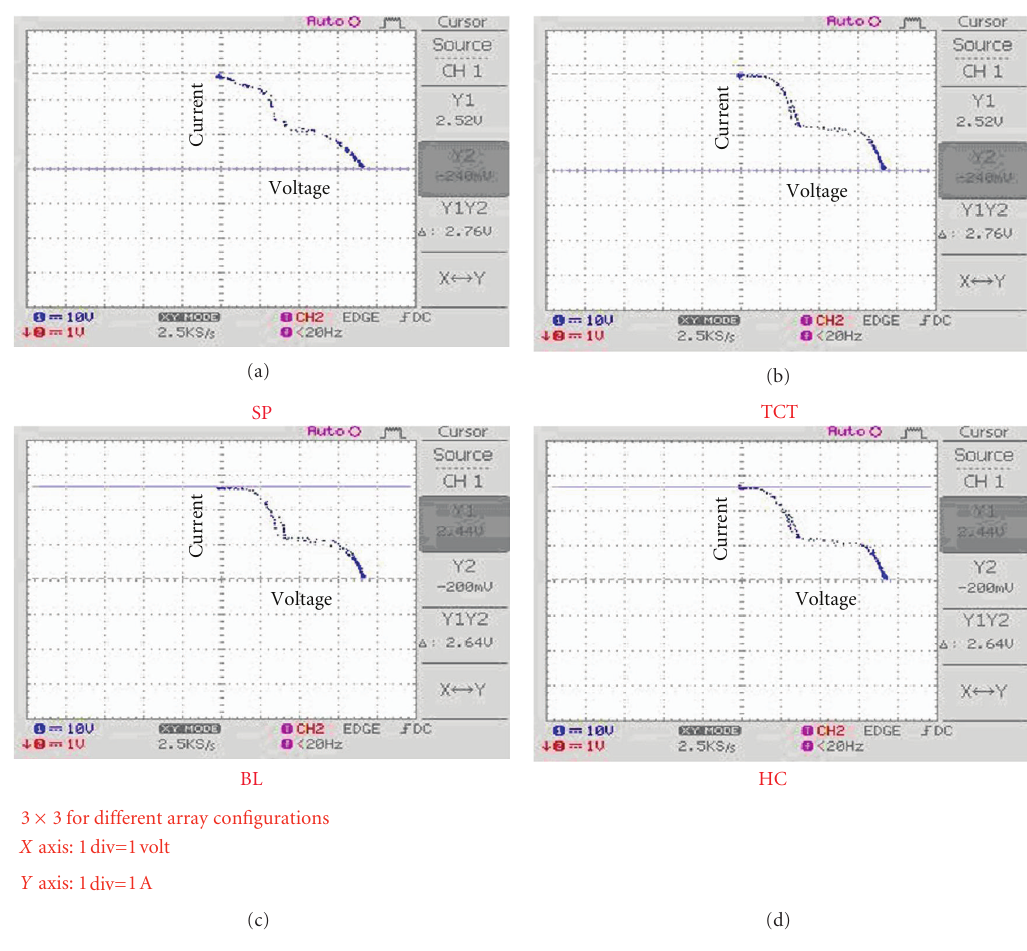
Figure 11: Snapshot of I-V characteristics for a 3 × 3 SPVA for di ff erent configurations.